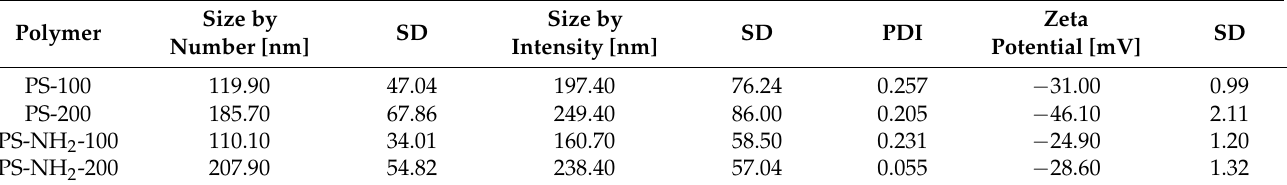
Table 1. The parameters characterizing the polymers (0.155 M NaCl, pH = 7.4).